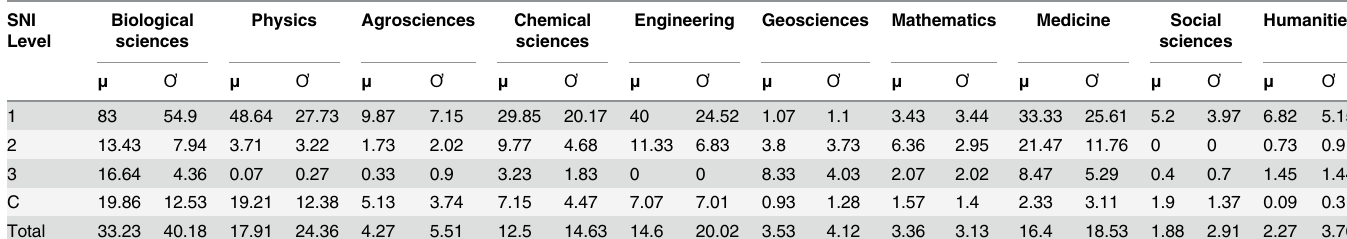
Table 13. Distribution of means ( μ ) and standard deviations ( Ơ ) of papers published by each level of researchers in the SNI system by area of knowledge. SNI Biological Level